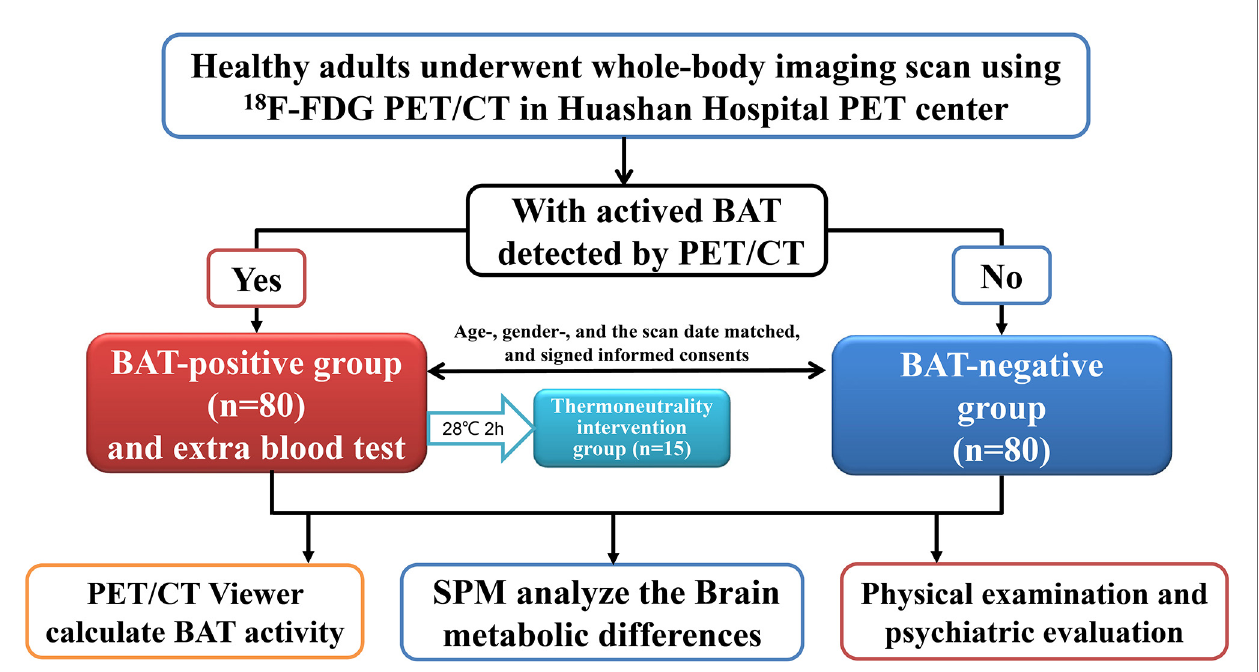
FIGURE 1 | Subjects and Work fl ow. Flowchart of the PET/CT study: This research is a cross-sectional control study with a large sample. Subjects were divided into two groups according to 18 F-FDG uptake of BAT detected by PET-CT. Eighty healthy adults with activated BAT detected by PET/CT scan were recruited as the BAT positive group, while each BAT positive subject was matched to a healthy adult without activated BAT detected by PET/CT scan on the same day, with the same gender, and similar age ( ± 5 years), who became the BAT negative control group. There were 15 BAT positive subjects who volunteered to stay in thermoneutrality (28°C, two hours), repeat the PET/CT scan, and take a blood test for the NPY level. Every subject performed the whole-body PET/CT scan, the physical examination, and the blood